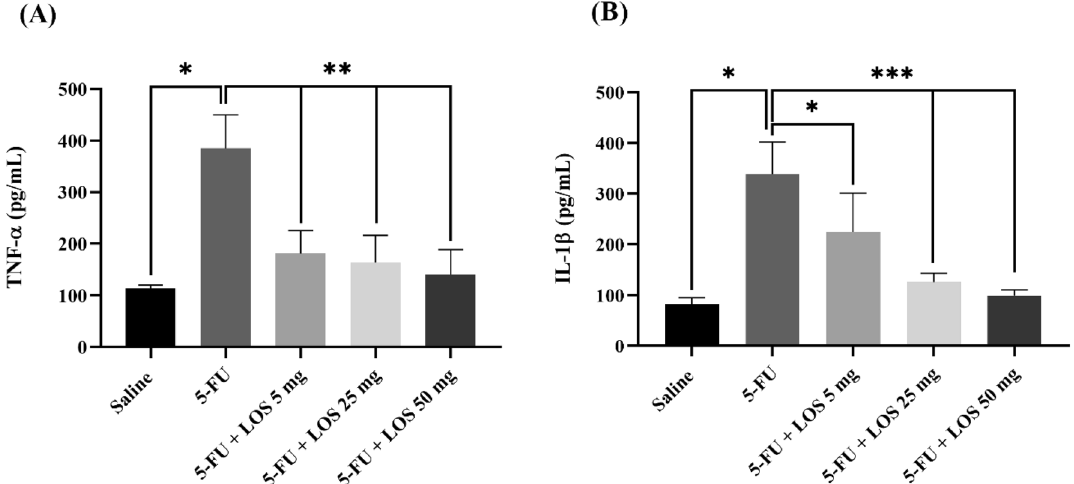
Figure 4. Cytokines tumor necrosis factor alpha (TNF-α) ( A ) and interleukin 1 beta (IL-1β) ( B ) in the jejunal portion of mice submitted to the experimental model of intestinal mucositis (IM). The saline group comprised animals without IM; In the 5-FU group, the animals received 5-FU and without treatment. The LOS groups received 5-FU, underwent IM and were treated with losartan (orally), in doses (5, 25 or 50 mg/kg) (n = 5/group). The results are presented as mean ± standard error of the mean (n = 5/group). *p < 0.001 (compared to saline); **p < 0.0001 (compared to 5-FU) (ANOVA analysis of variance with the Tukey post-test).